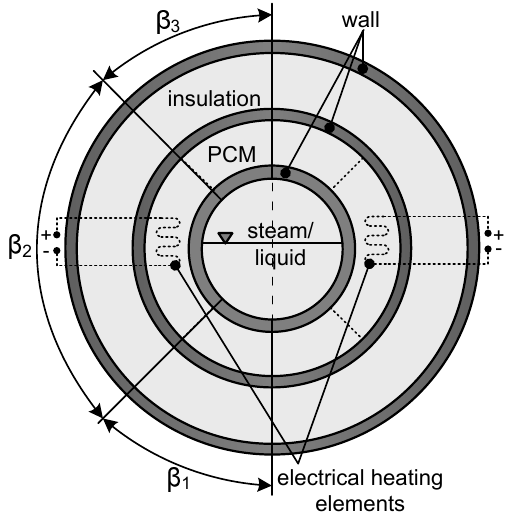
Figure 1. Hybrid storage